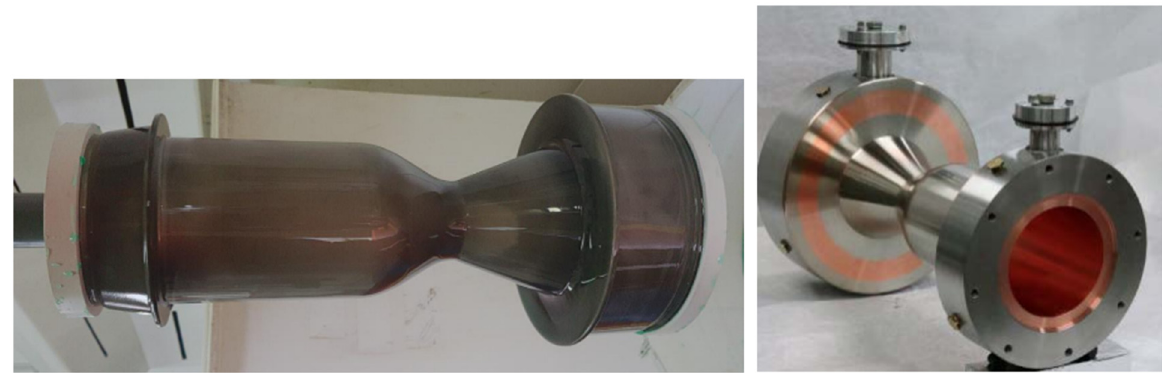
Figure 4. Pictures of DEMO-0A in the manufacturing phase and after the completion of realization phase [17].